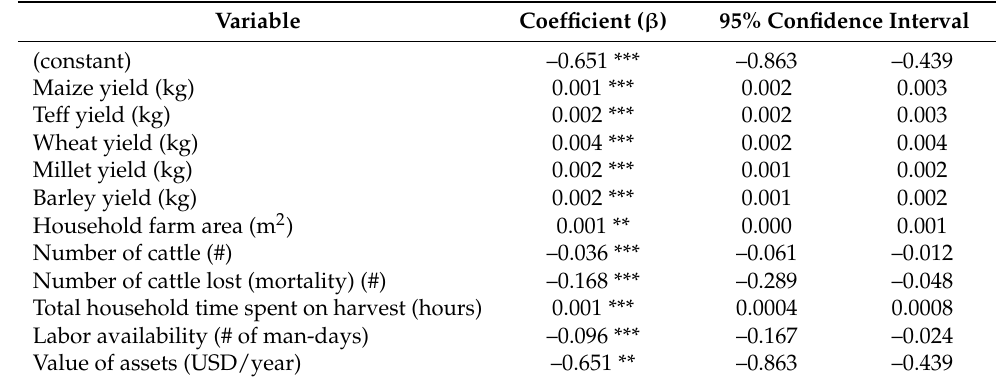
Table 6. Bi-logit model estimation of willingness to use chemical fertilizer ( n =